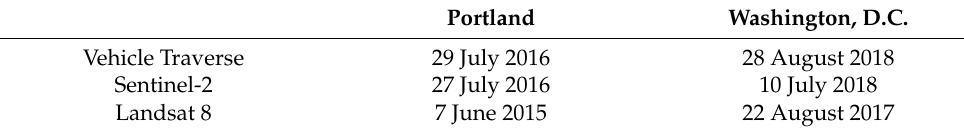
Table 2. Acquisition dates for vehicle traverse and Sentinel-2 and Landsat 8